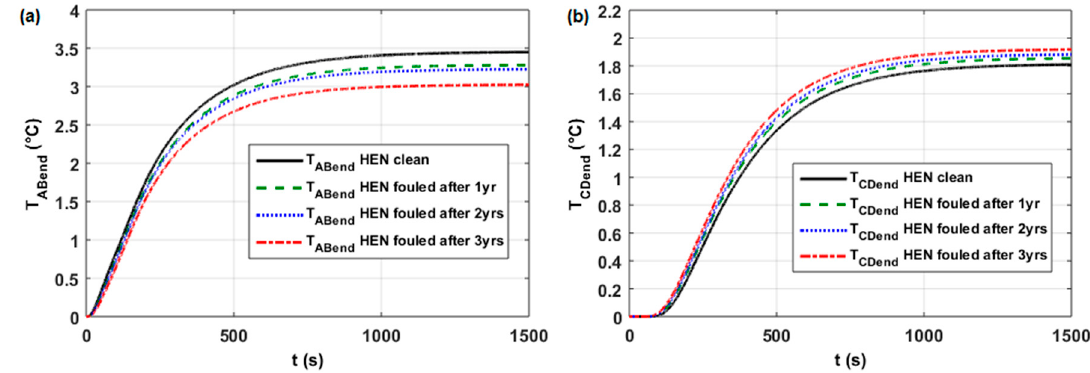
Figure 12. Open-loop responses of the HEN models (( a ) – the end temperature T ABend and ( b ) – the end temperature T CDend , after parallel branches) to +10% step change in the shell-side flowrate of selected exchangers.